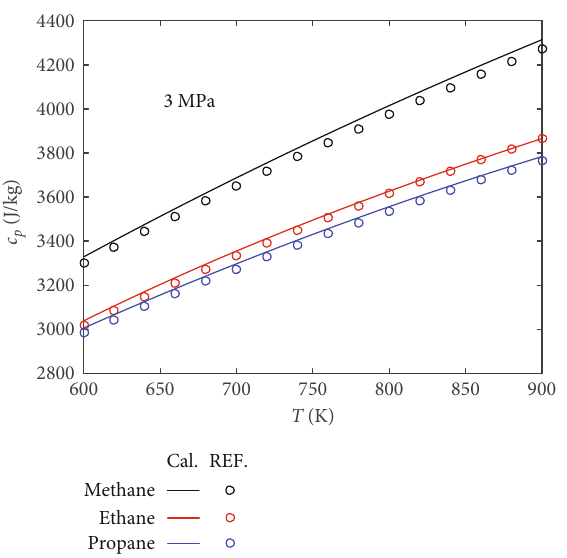
Figure 6: Comparison of enthalpies of methane, ethane, and propane under 3 MPa.